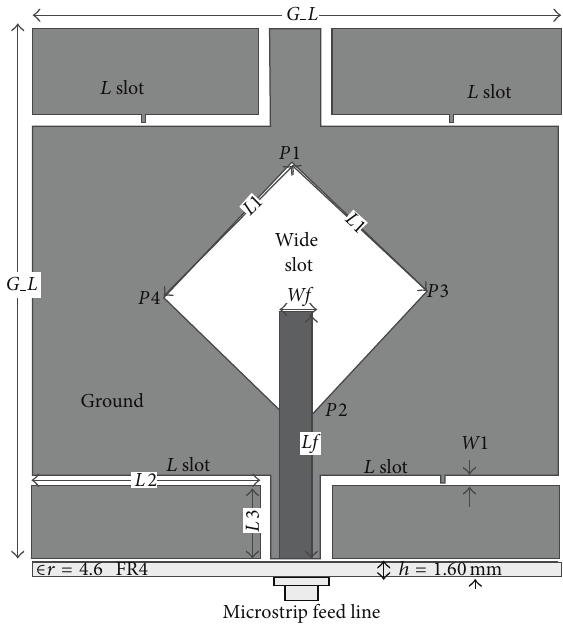
Figure 1: Proposed antenna